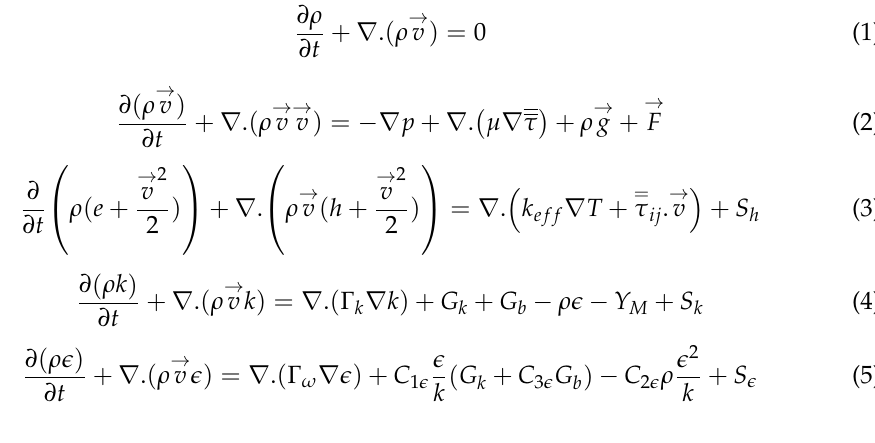
Table 2. Properties of water employed in the simulation. Property Value ρ , (cid:2) kg / m 3 (cid:3) 997.1 C p , [ J / ( kg . K )] 4182 k , [ W / ( m . K )]